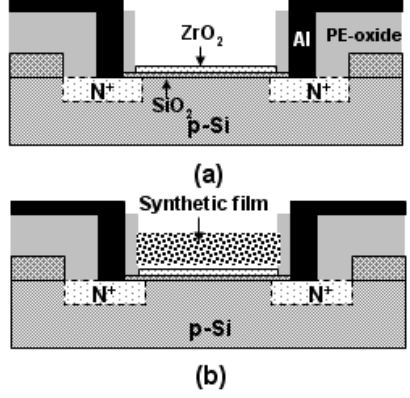
Figure 2. Schematic diagrams of (a) ISFET (b) EnFET and